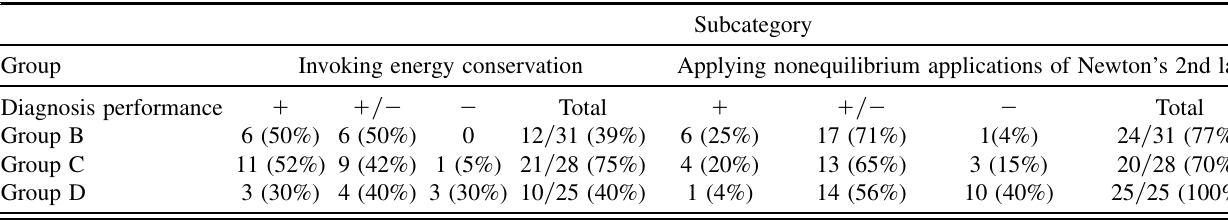
TABLE IX. Analysis of self-diagnosis subcategories.